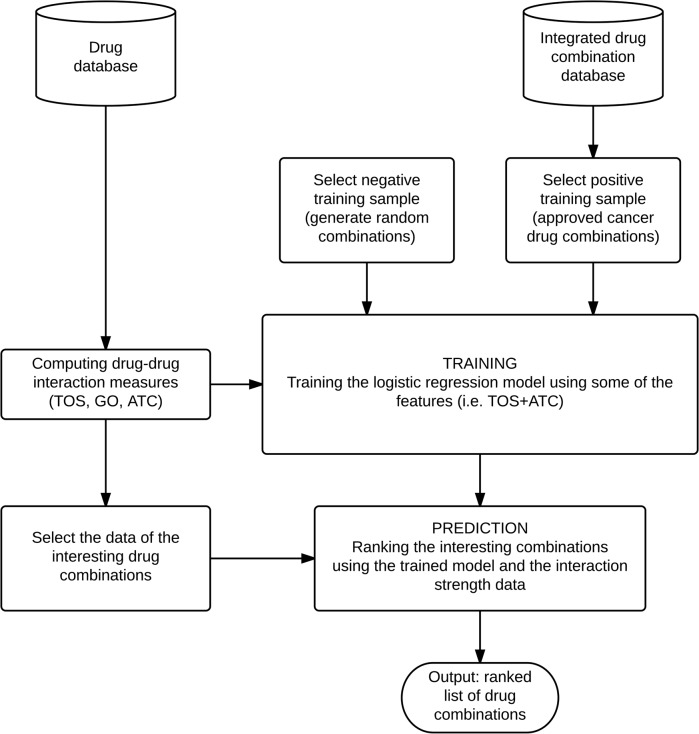
Flow chart of the training procedure.The input is a list of candidate combinations (i.e. combinations selected for clinical trials) and the set of known combinations (i.e. previously approved cancer combinations). The first step is to compute the Target Overlap Score (TOS) and the drug interaction measures (GO, ATC) for all possible drug combinations. The database consists of the random generated drugs and of the components of the candidate and the known combinations. After the selection of the training sample (both the positive—known cancer combinations—and the negative one—random combinations) a logistic regression was trained using the previously computed TOS and similarity values. In the next step the trained model is used for ranking a set of candidate combinations. The output is the ranked list of the drug combinations.